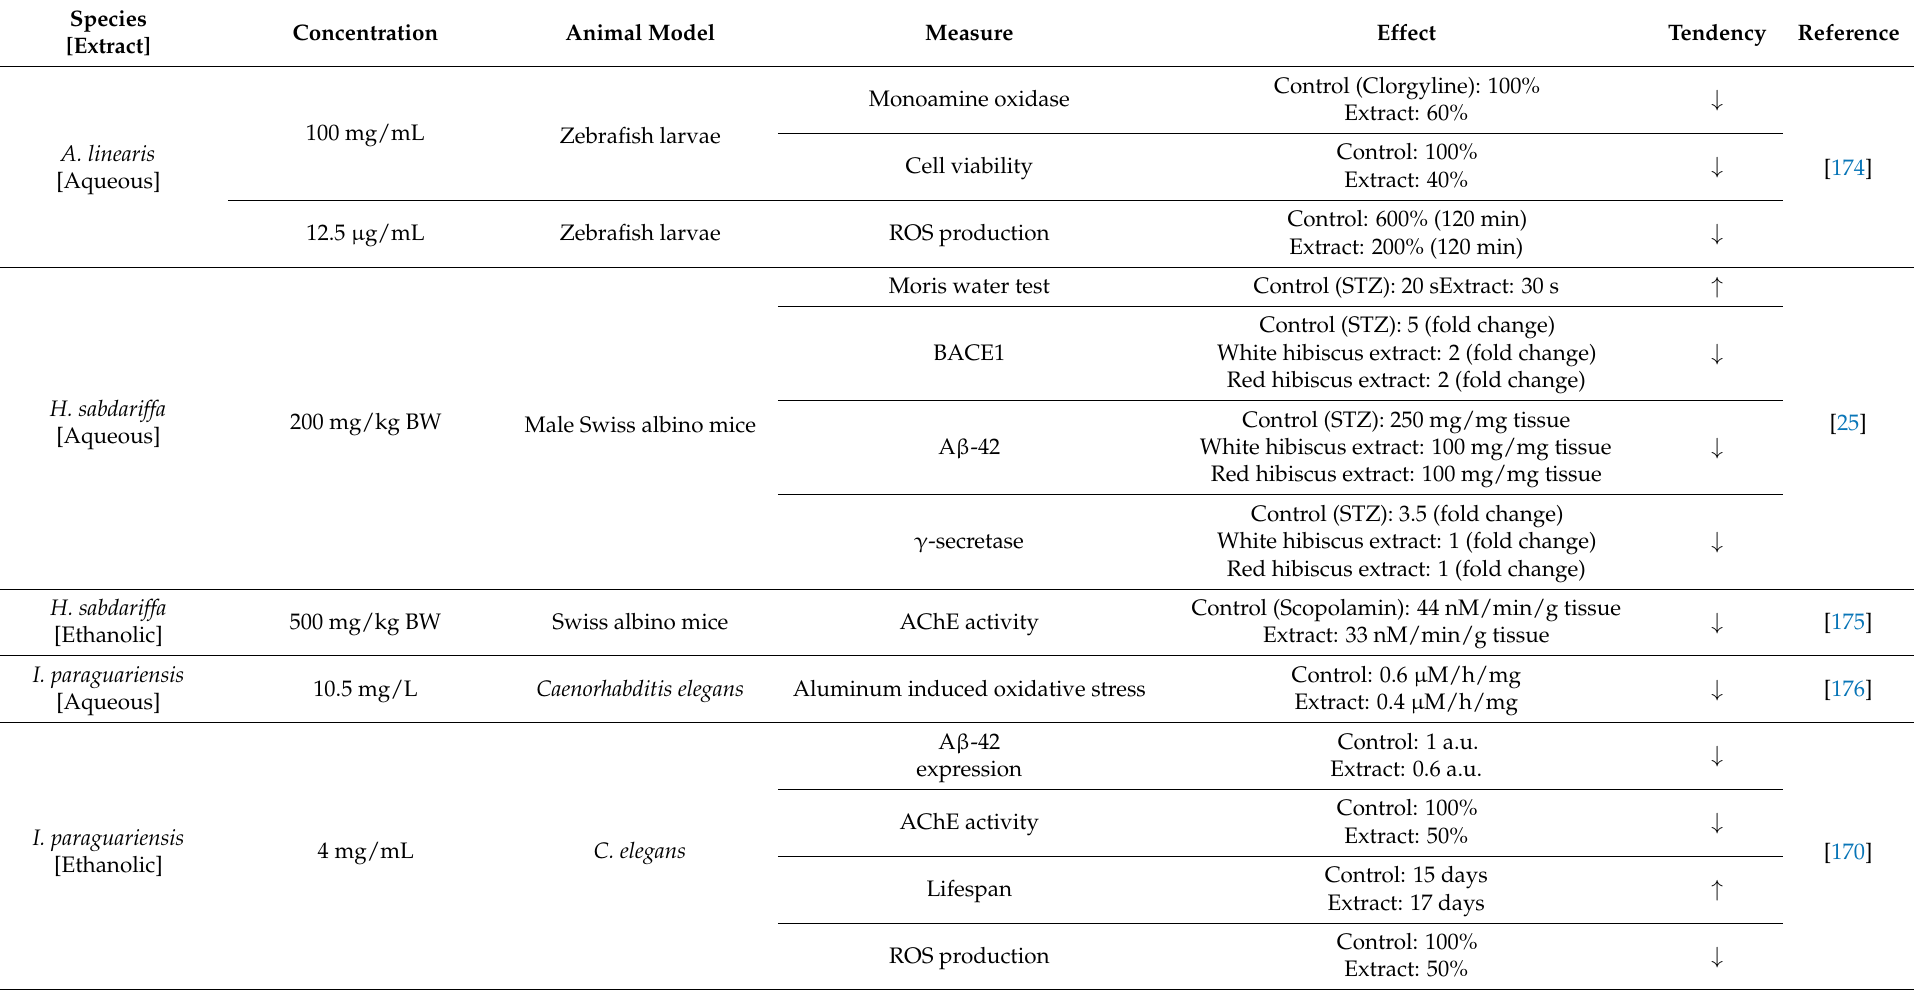
Table 6. In vivo neuroprotective effects of rooibos, hibiscus, yerba mate